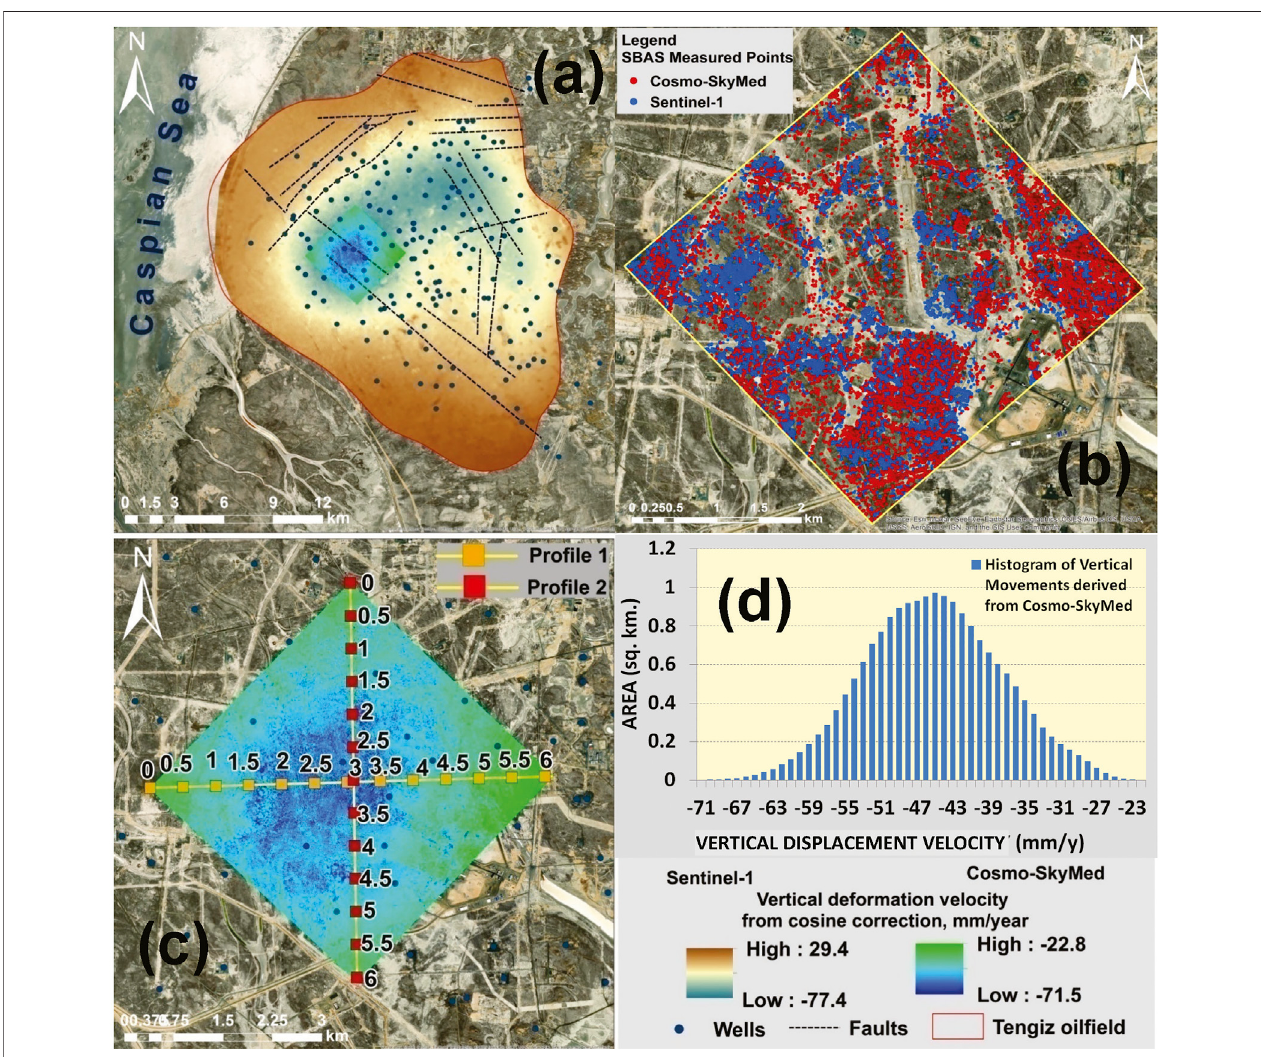
FIGURE 8 | (A) Map of the spatially interpolated vertical displacement velocity derived from the Sentinel-1 and COSMO-SkyMed satellite images; (B) SBAS measured points from the Sentinel-1 and COSMO-SkyMed satellite images used for the spatial interpolation; (C) pro fi le lines of vertical displacement velocity derived from the COSMO-SkyMed images; (D) histogram of vertical displacement velocities derived from the COSMO-SkyMed satellite images.